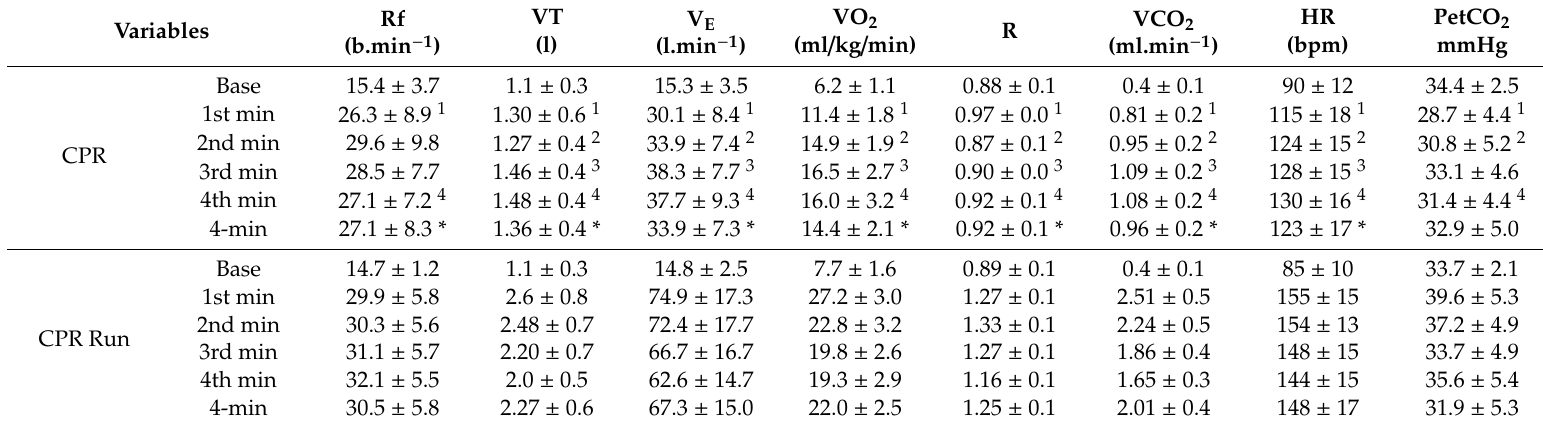
Table 1. Mean ± SD values for the cardio-pulmonary variables assessed during baseline (base) and over each minute and over the 4-min in sessions 1 (CPR) and 2